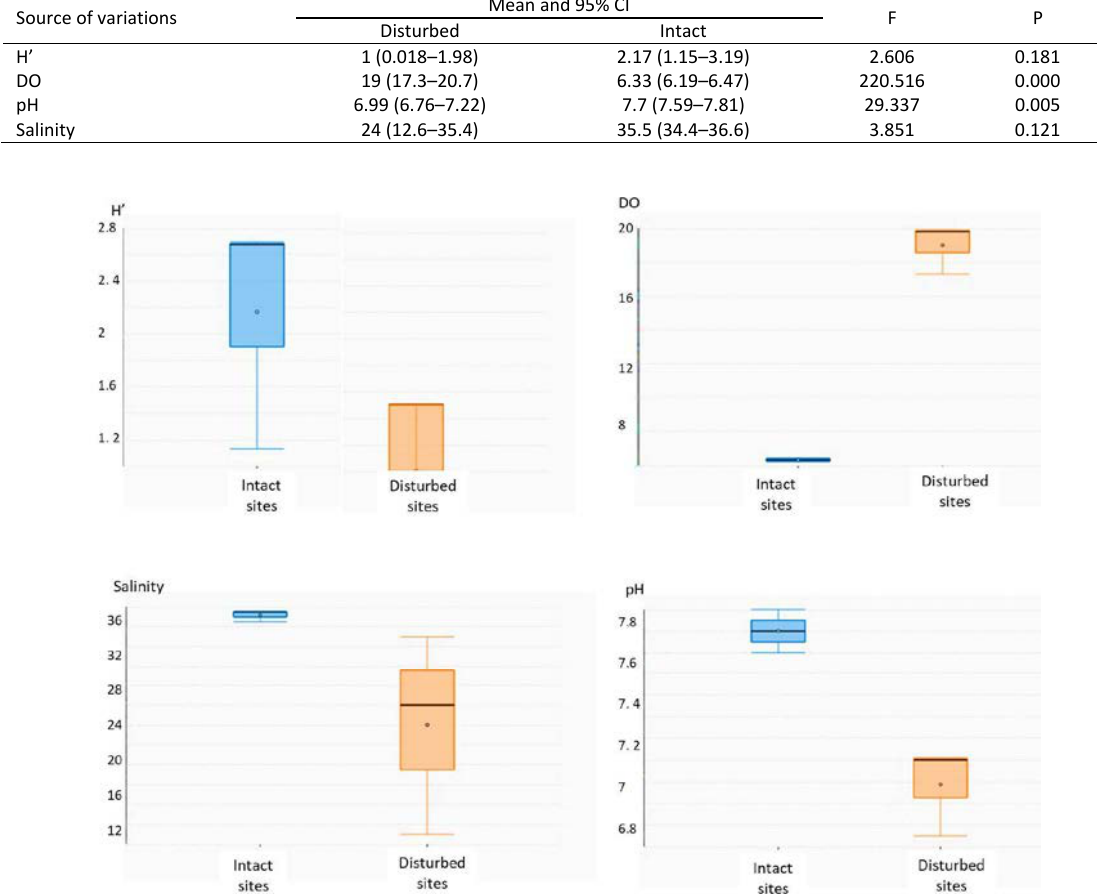
Fig. 4: Comparisons of H’, DO, salinity, and pH between disturbed (a) and intact (b) sites on West Java coast